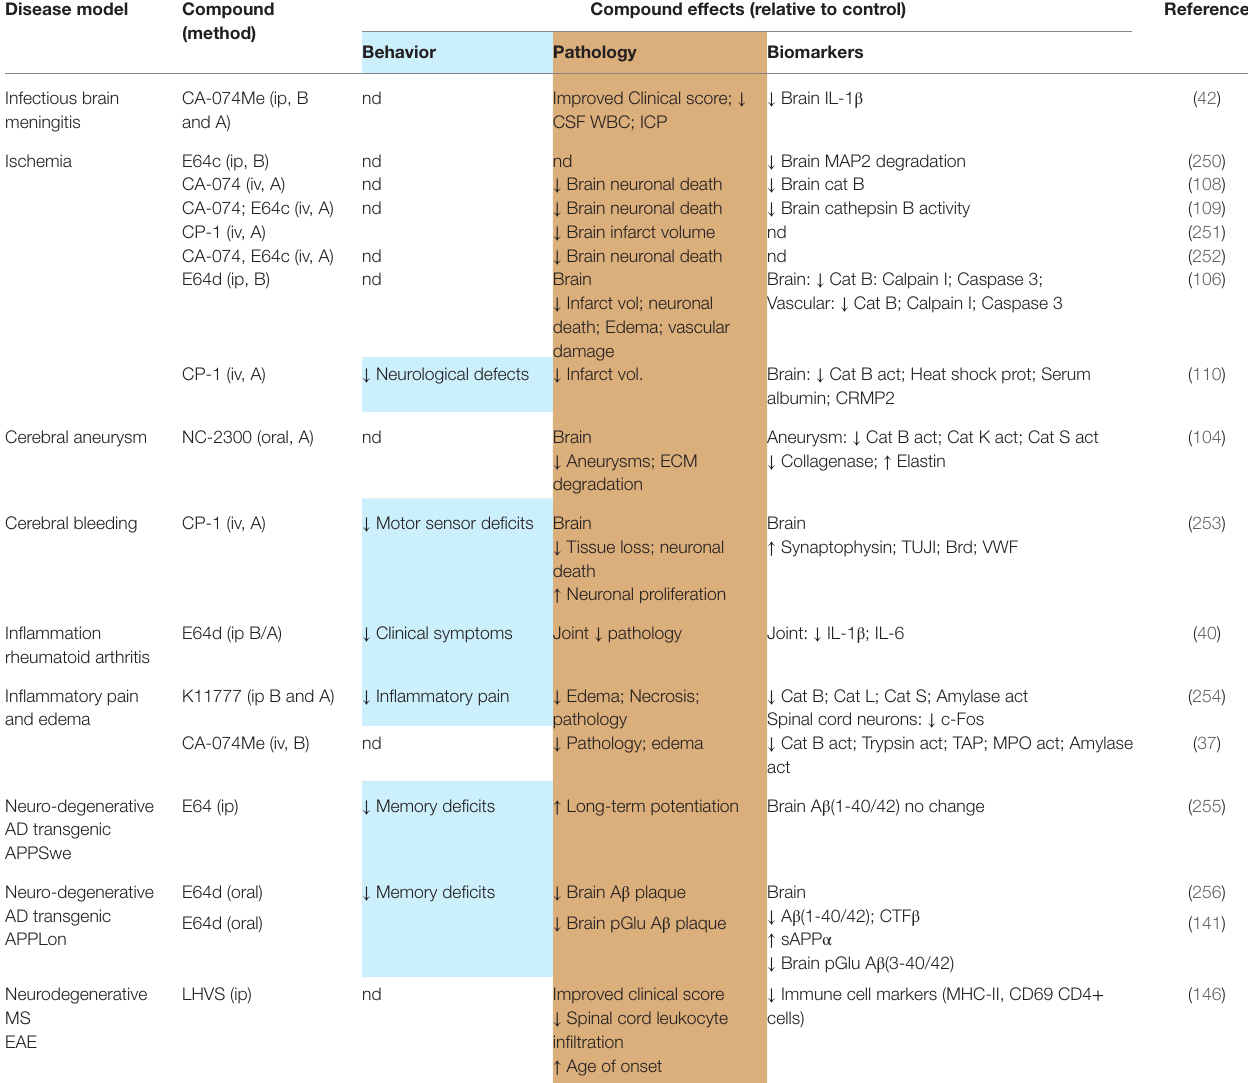
Table 6 summarizes the data showing the behavioral, patho- logical, and biomarker effects of administering small molecule inhibitors of cathepsin B to TBI and TBI-related injury